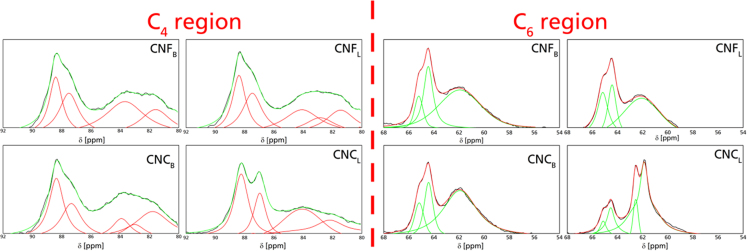
Fitted curves for the C4 and C6 regions as obtained by 13C NMR.